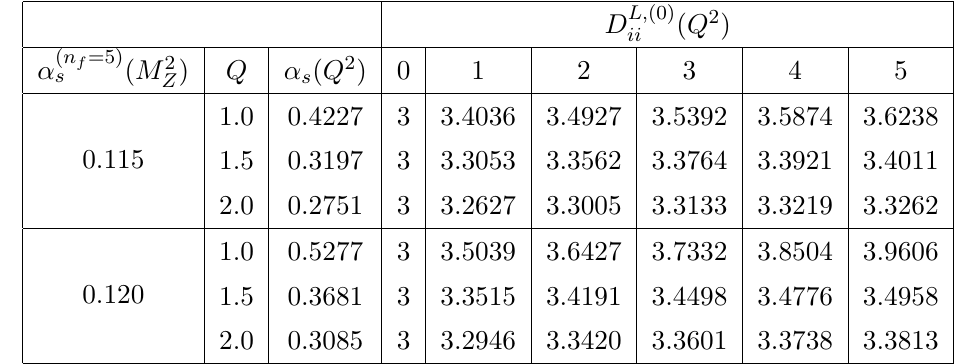
Table 1 . Values of α s ( Q 2 ) with n f = 3 (left) at different scales Q (in GeV units) for two input choices of α ( n f =5) s ( M 2 ) . The corresponding values of D L, (0) ( Q 2 ) are given in the right columns Z ii at different orders in α s ( Q 2 ) . Our central value for the fifth-order coefficient, K 5 = 275 , has been adopted in the last column.